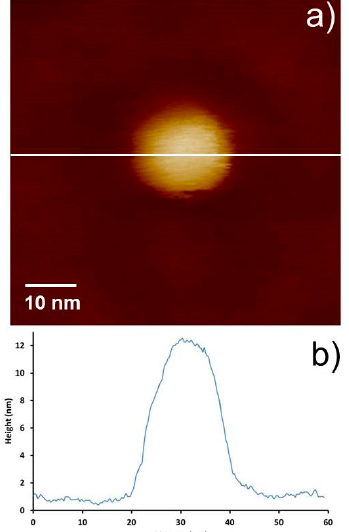
Figure 9. AFM image of a gold nanoparticle on silicon using CNT4. ( b ) shows the cross section that corresponds to the positon of the white line in ( a ). The “pit” artefact is significantly reduced due to the increased lateral stability of CNT4, due to the CNTs relative thickness. The height or color scale for the image is 20 nm.